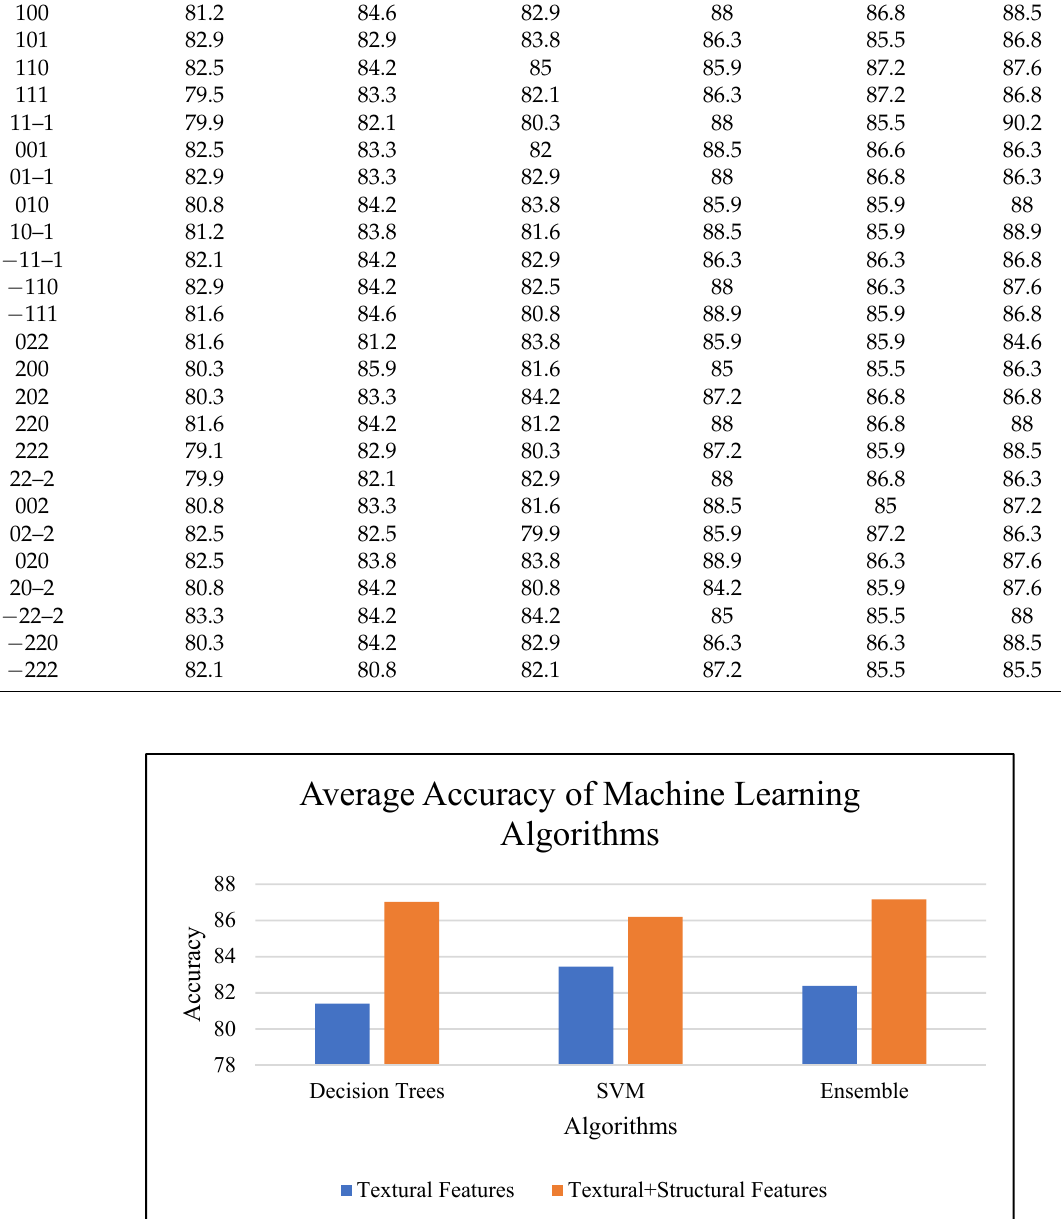
Figure 14. Average accuracy for top-performing machine learning algorithms. Table 6. Classification accuracy based on texture analysis and machine learning techniques.